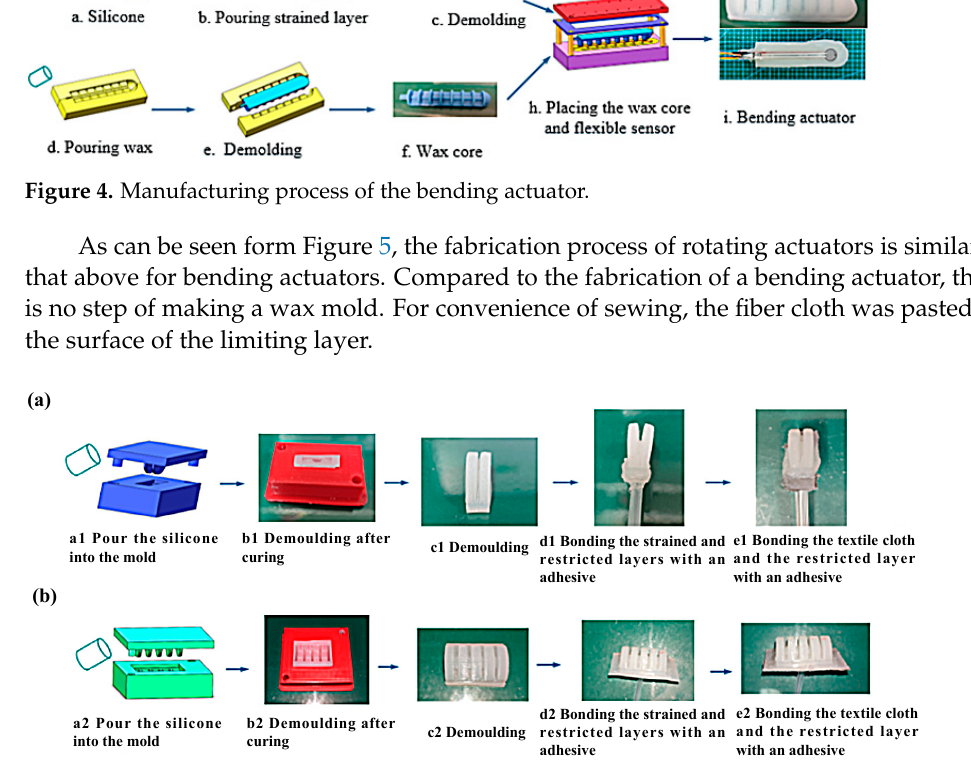
Figure 5. Fabrication process of rotating actuator: ( a ) the normal rotating actuator and ( b ) the thumb.